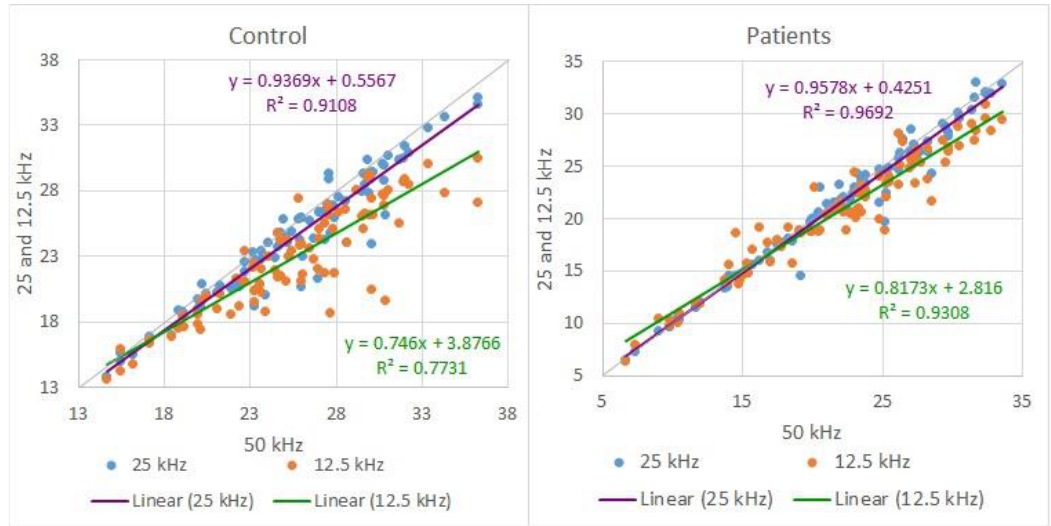
Figure 7. Comparative analysis of the HNR with 25 and 12.5 kHz over 50 kHz sampling frequency.